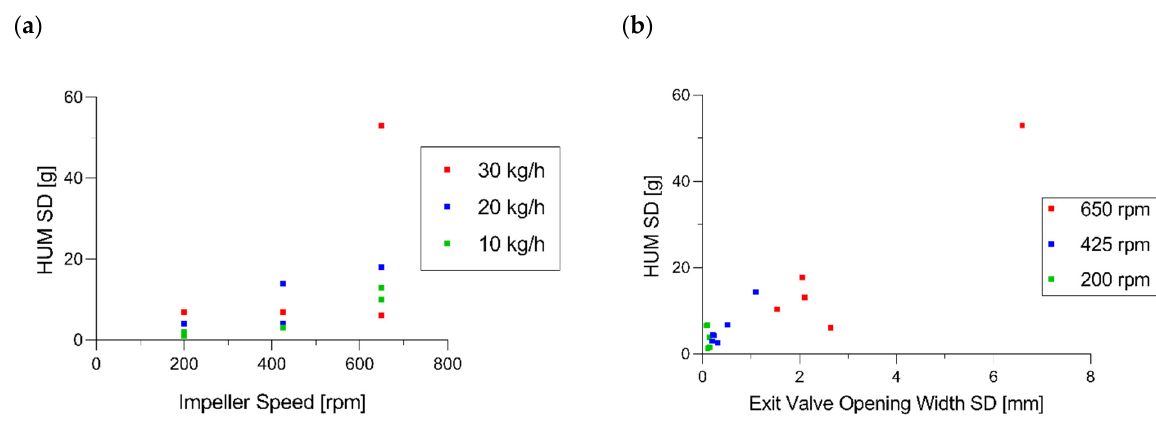
Figure 13. ( a ) HUM standard deviation as a function of impeller speed. ( b ) Dependencies between SD in EV and HUM.